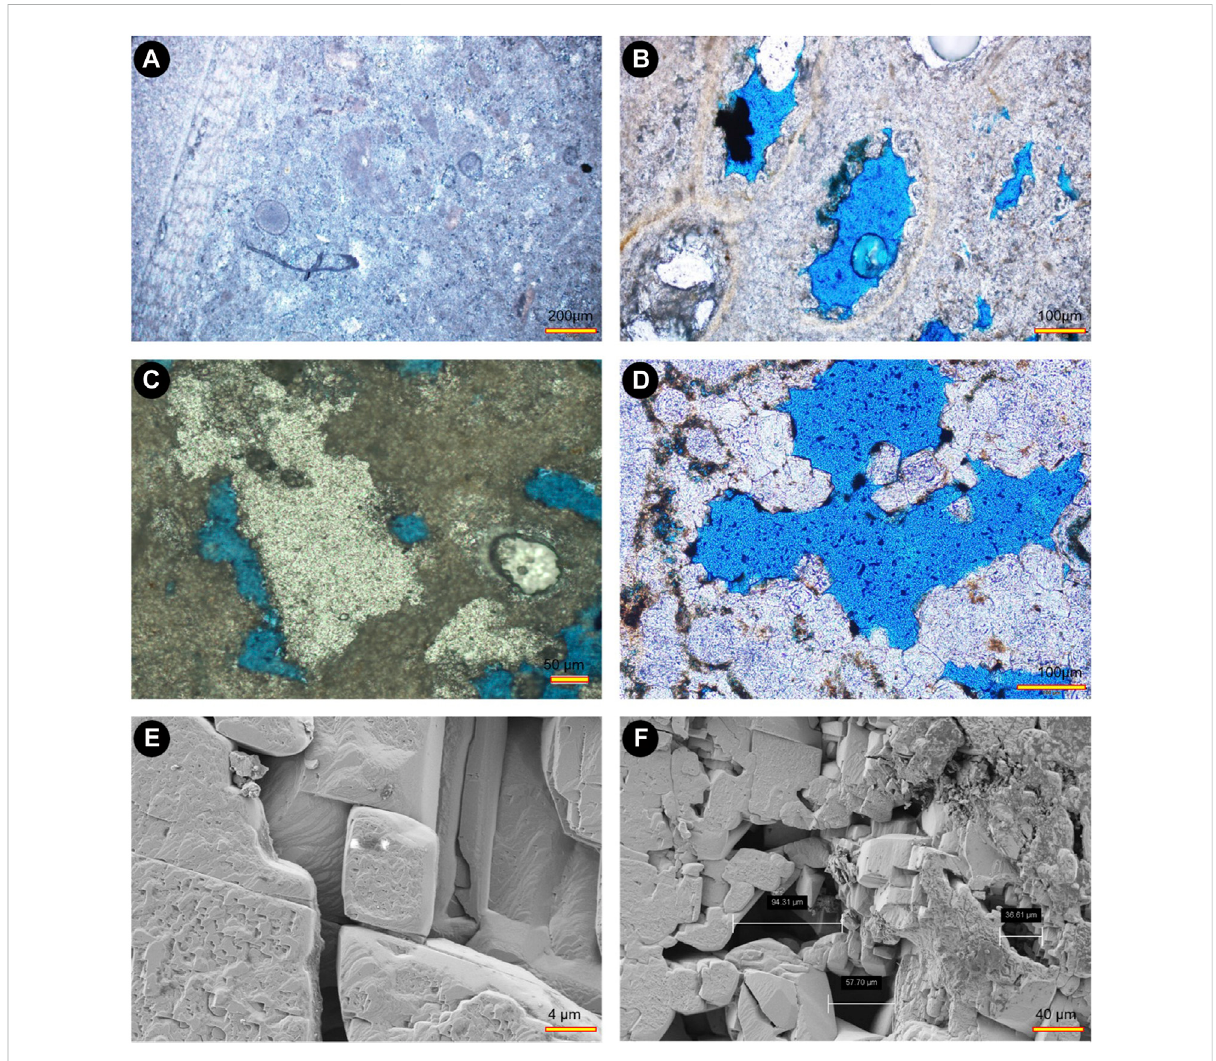
FIGURE 3 Petrographic images of the samples. (A) Image shows the thin section of coralline fl oatstone facies. (B) Image shows the fossil grain ’ s partial dissolution, creating a moldic porosity. (C) Blocky-drusy calcite cement replacement represents a brighter color. (D) Dolomite crystal sizes